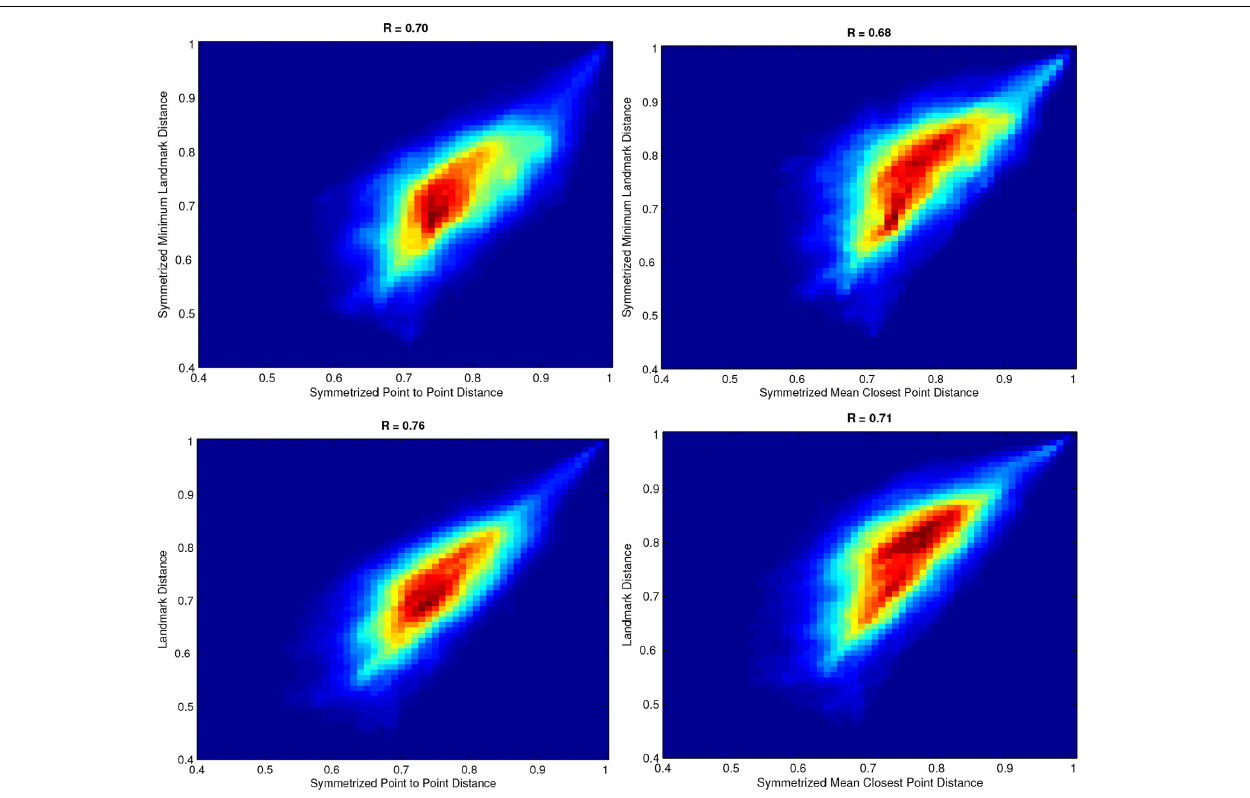
FIGURE 2 | 2-D Histograms of affinity matrices using different similarity measure.Top-Left symmetrizedminimumlandmarkdistancevs.symmetrized point to point distance. Top-Right symmetrized minimum landmark distance